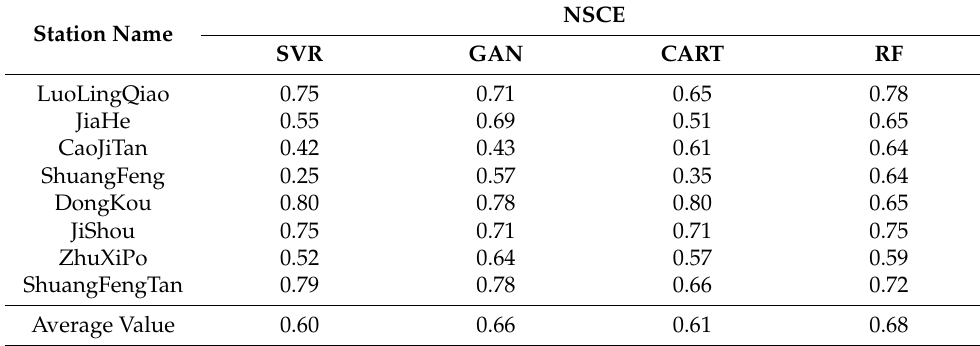
Table 7. Transplant results of machine learning methods.